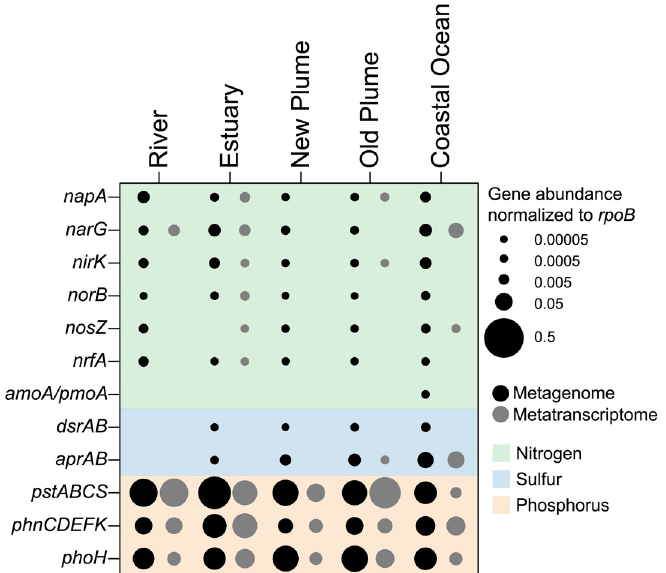
Fig 4. Abundance and expression of key genes involved in nitrogen, sulfur, and phosphorus transport and metabolism. The size of the bubble corresponds to the normalized abundance or expression of each gene. Black bubbles represent metagenomes, gray bubbles represent metatranscriptomes. Gene abbreviations are as follows: napA and narG , nitrate reductase; nirK , nitrite reductase; norB , nitric oxide reductase; nosZ , nitrous oxide reductase; nrfA , nitrite reductase to ammonia; amoA/pmoA , ammonia/ methane monooxygenase; dsr , dissimilatory sulfite reductase; apr , adenosine-5 0 -phosphosulfate reductase; pst , high-affinity phosphate transporter; phn , phosphonate transport; phoH , phosphate starvation-inducible protein.